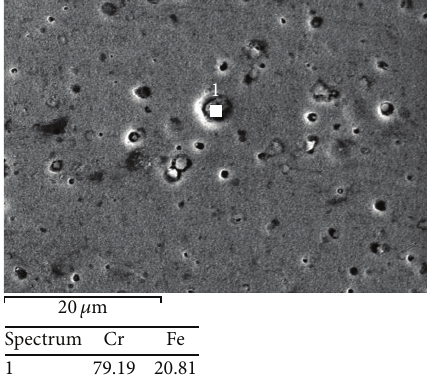
Figure 4: Droplet corrosion in CrN coating.